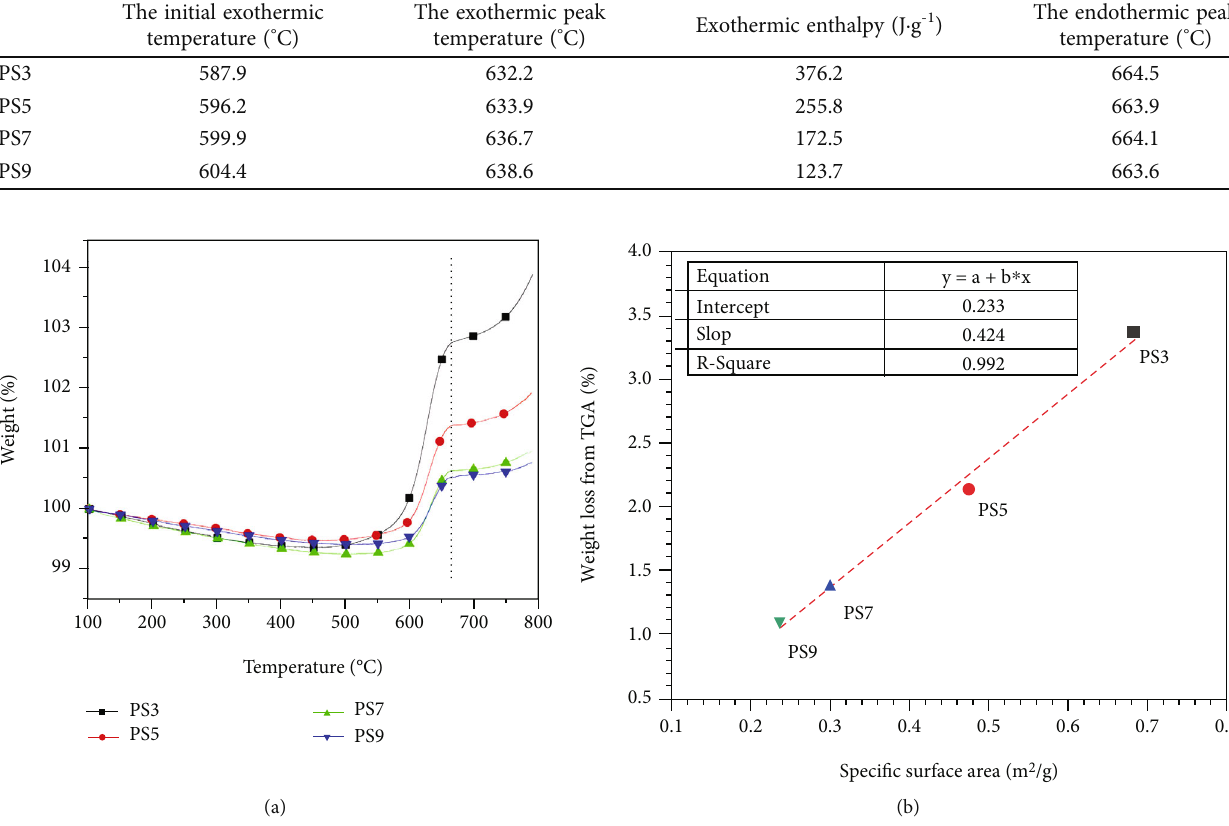
Figure 5: (a) TG curve of four Al powders and (b) relation diagram of thermal weight gain and speci fi c surface area of Al powders. Table 4: The resistivity of four aluminum pastes printed on di ff erent substrates.